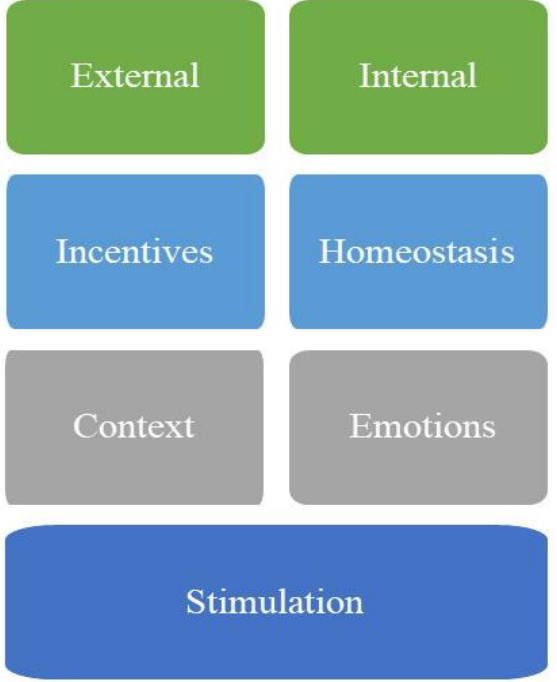
Figure 6. External and Internal